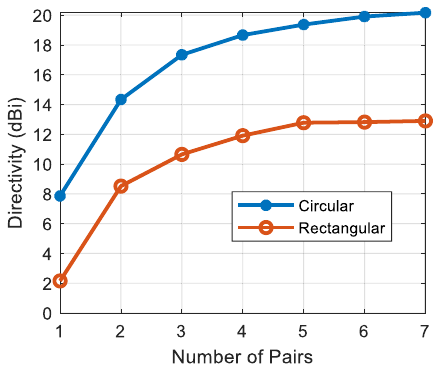
Figure 9. Directivity for each number of dielectric slabs